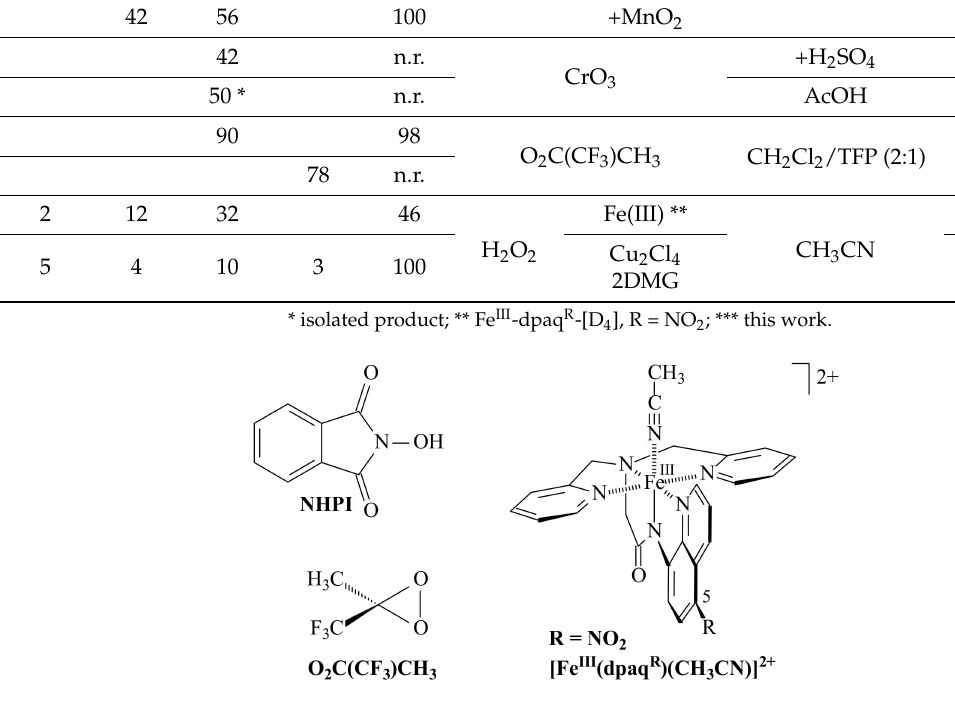
Scheme 6. Oxidants and catalytic complex for one-stage synthesis of 3a and 4a